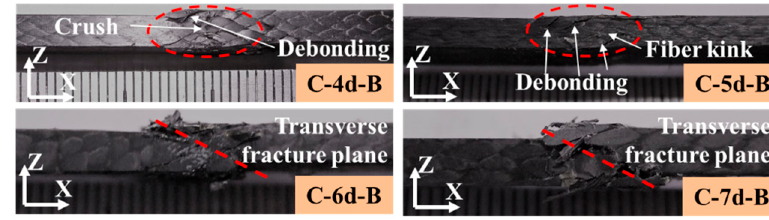
Figure 14. Compressive failure of 3DBC with a braiding angle of 40° .